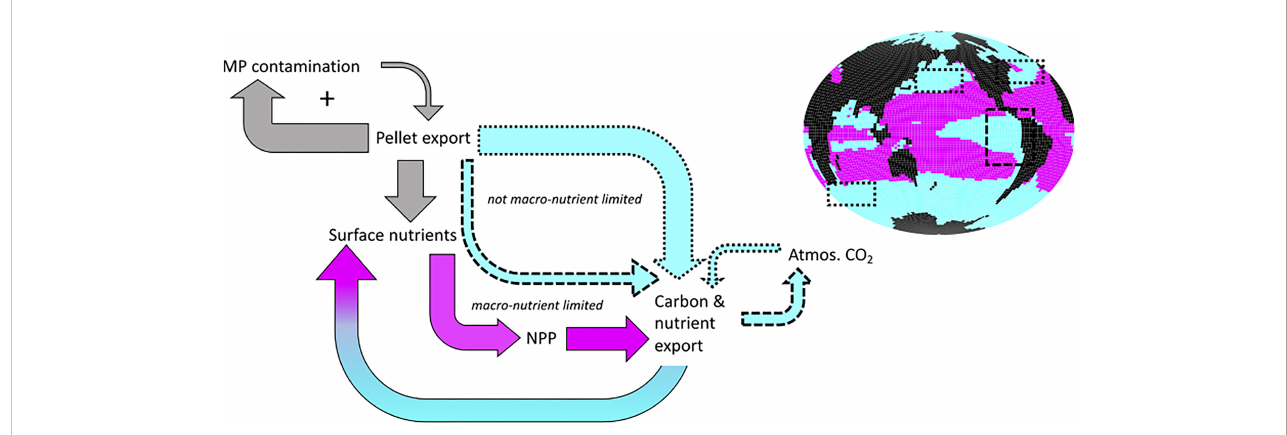
FIGURE 15 Microplastic biogeochemical effects and feedbacks in SLOW small . Increases are shown with fat arrows, decreases are shown with thin arrows. Grey colour denotes global ocean surface effects, blue colour denotes surface effects dominating in nutrient replete regions, and pink colour denotes surface effects dominating in nutrient limited regions. Impacts on air-sea gas exchange are negligible over human timescales. The plus symbol indicates a positive feedback on microplastic